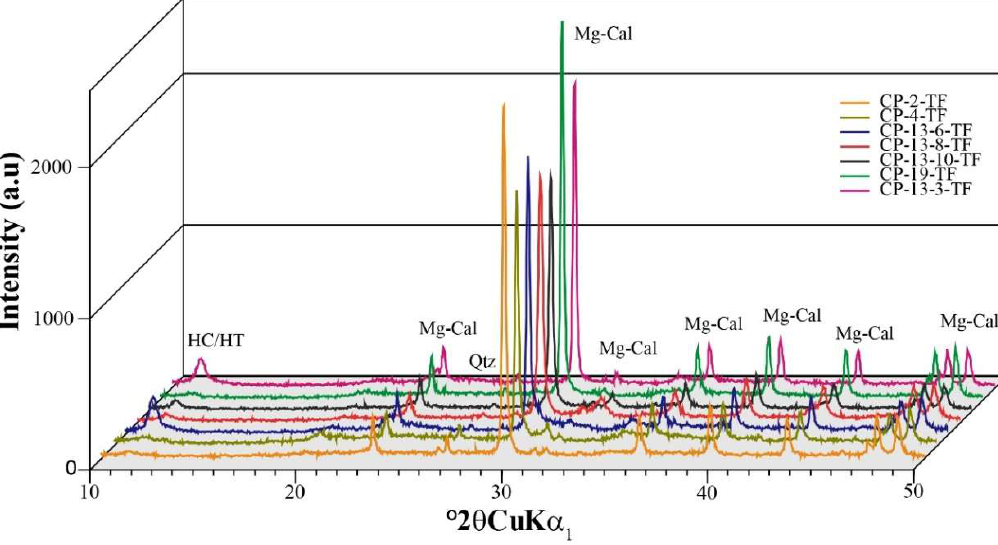
Figure 9. X-ray diffraction patterns of target fractions of different mortar binders. HC: hydrocalumite, HT: hydrotalcite, Mg-Cal: magnesium calcite, Qtz: Table 2. Semi-quantitative data results (%) of X-ray diffraction analyses of target and ultrafine fractions of mortar binders.